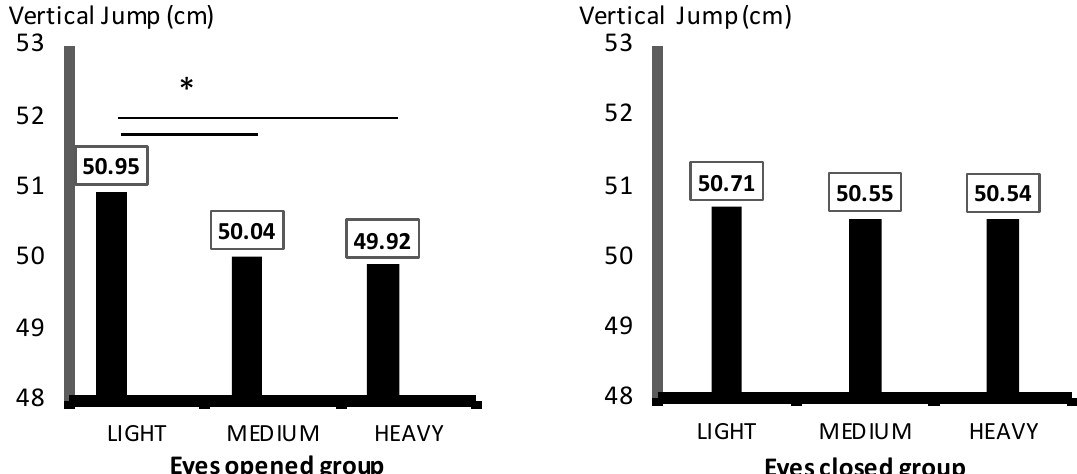
Figure 1. J umping values of eyes open and eyes closed group with 3 different shoe weights. Asterisk mark significant differences between shoe conditions (p<0.01). cm: centimeter.